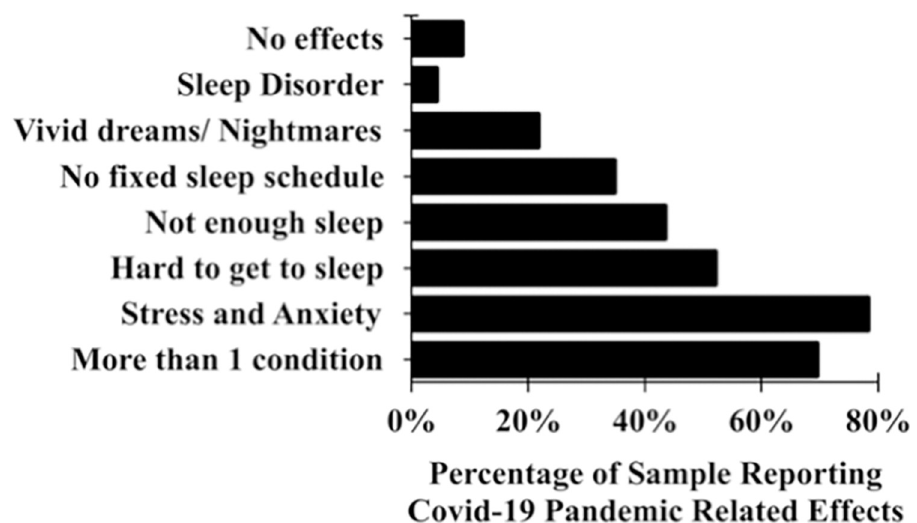
Fig 1. Proportion of participants reporting Covid-19 pandemic-related effects. 78% (18/23) of the participants reported that they felt an increase in stress and anxiety due to the pandemic; 52% (12/23) reported experiencing a harder time getting to sleep, 43% (10/23) felt that they were not getting enough sleep and 70% (16/21) reported suffering from more than one of the six effects listed, namely ‘sleep disorder’, ‘vivid dream/ nightmares’, ‘no fixed sleep schedule’, ‘not enough sleep’, ‘hard to get to sleep’ and ‘stress and anxiety’.